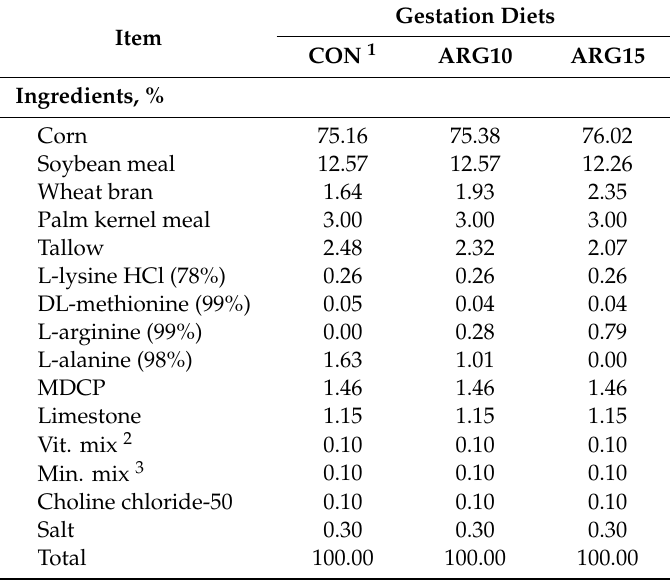
Table 1. The diet formulation and chemical composition of the experimental